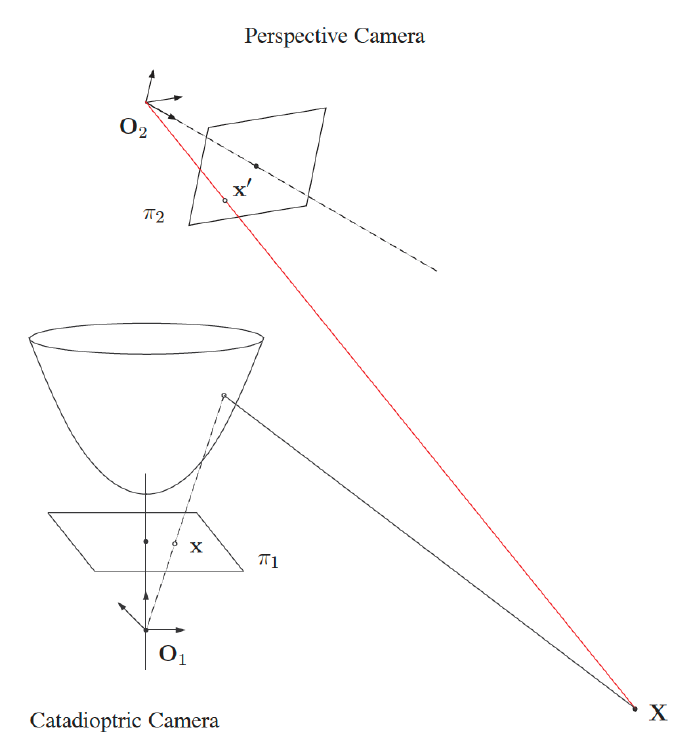
Figure 1. The catadioptric projection model of an omnidirectional camera. It consists of a hyperbolic mirror for reflection and a pinhole model for perspective